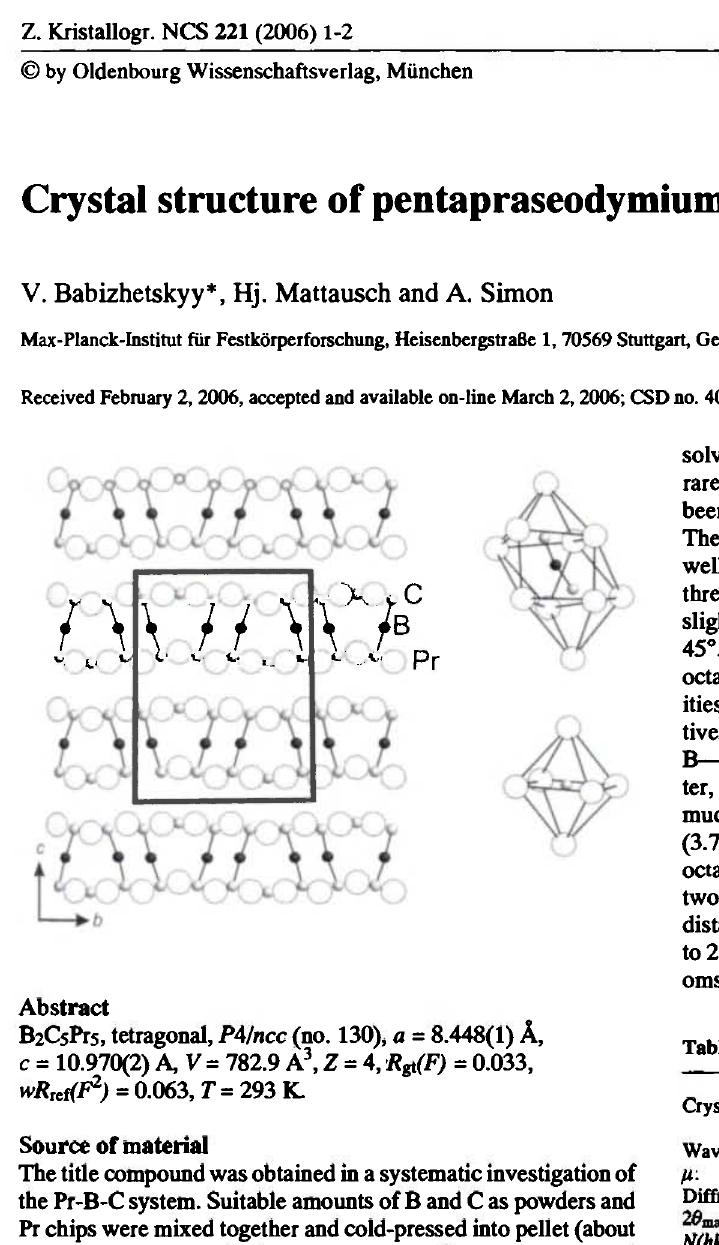
Table 2. Atomic coordinates and displacement parameters (in A 2 ).